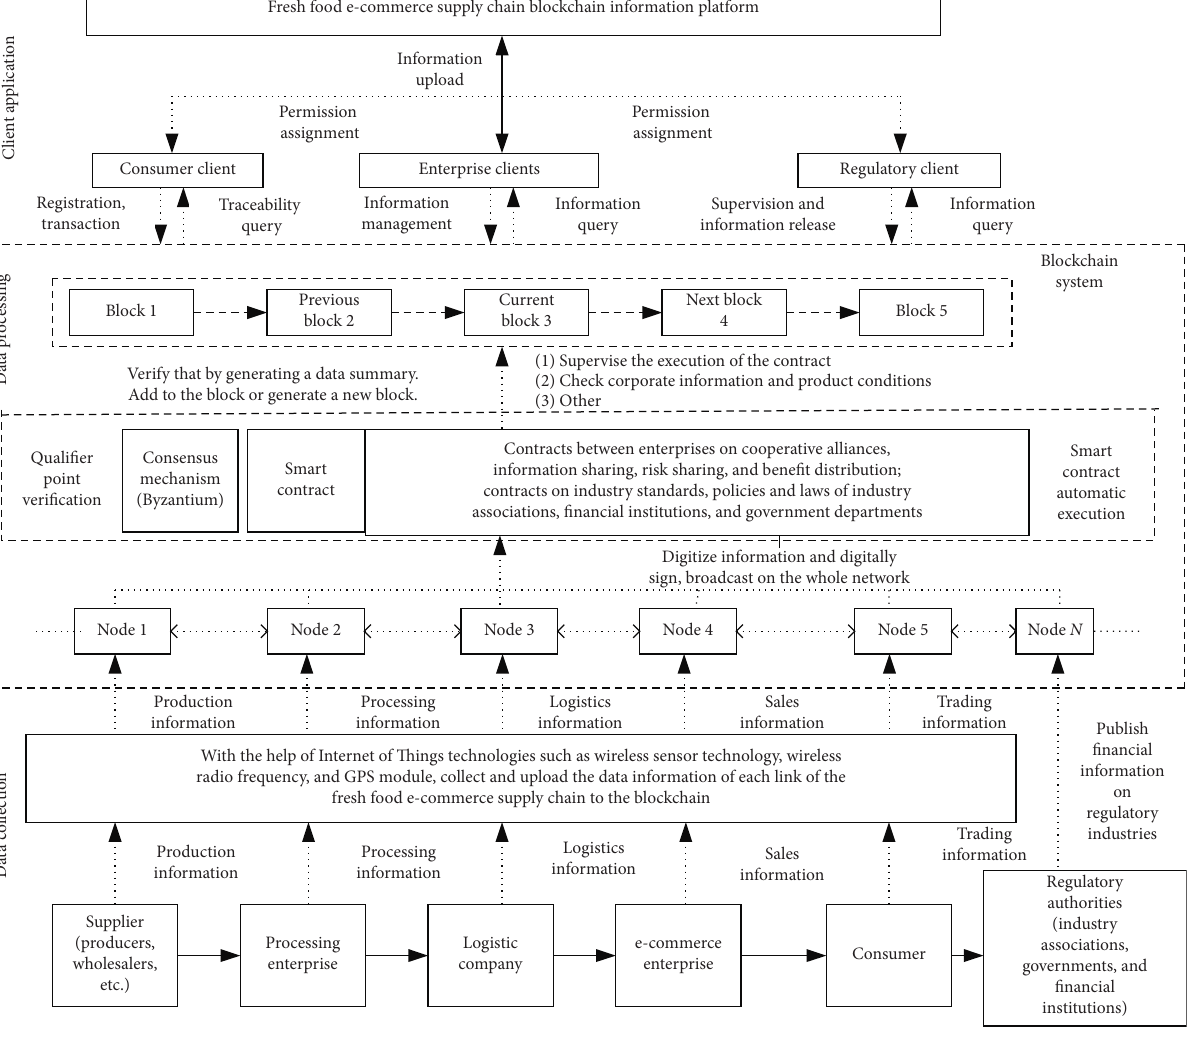
Figure 4: Blockchain information platform of fresh food e-commerce supply chain based on alliance